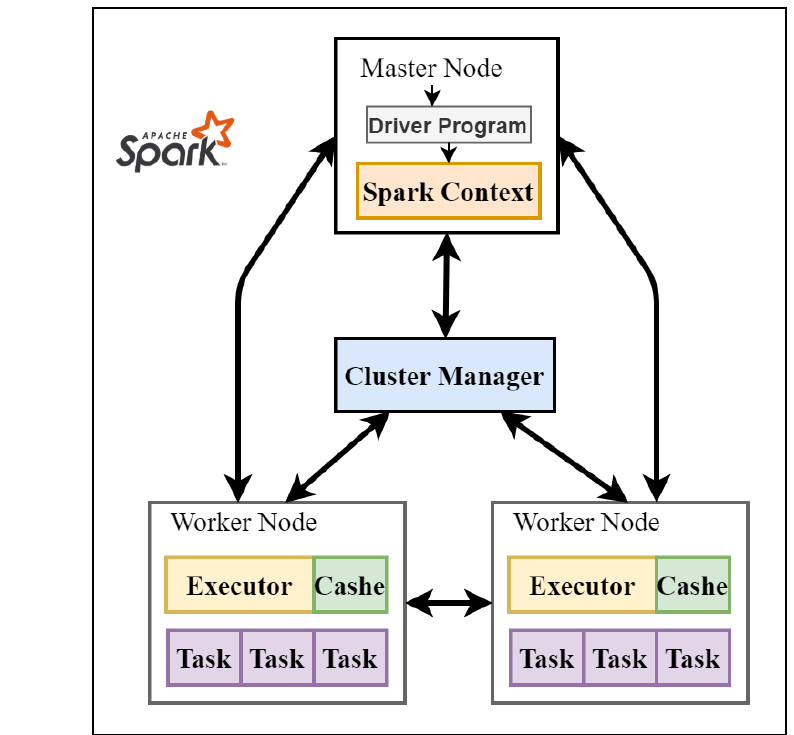
Figure 2. Overview of Spark framework. The master node contains driver program, which drives the application by creating Spark context object. Spark context object works with cluster manager to manage different jobs. Worker nodes job is to execute the tasks and return the results to Master